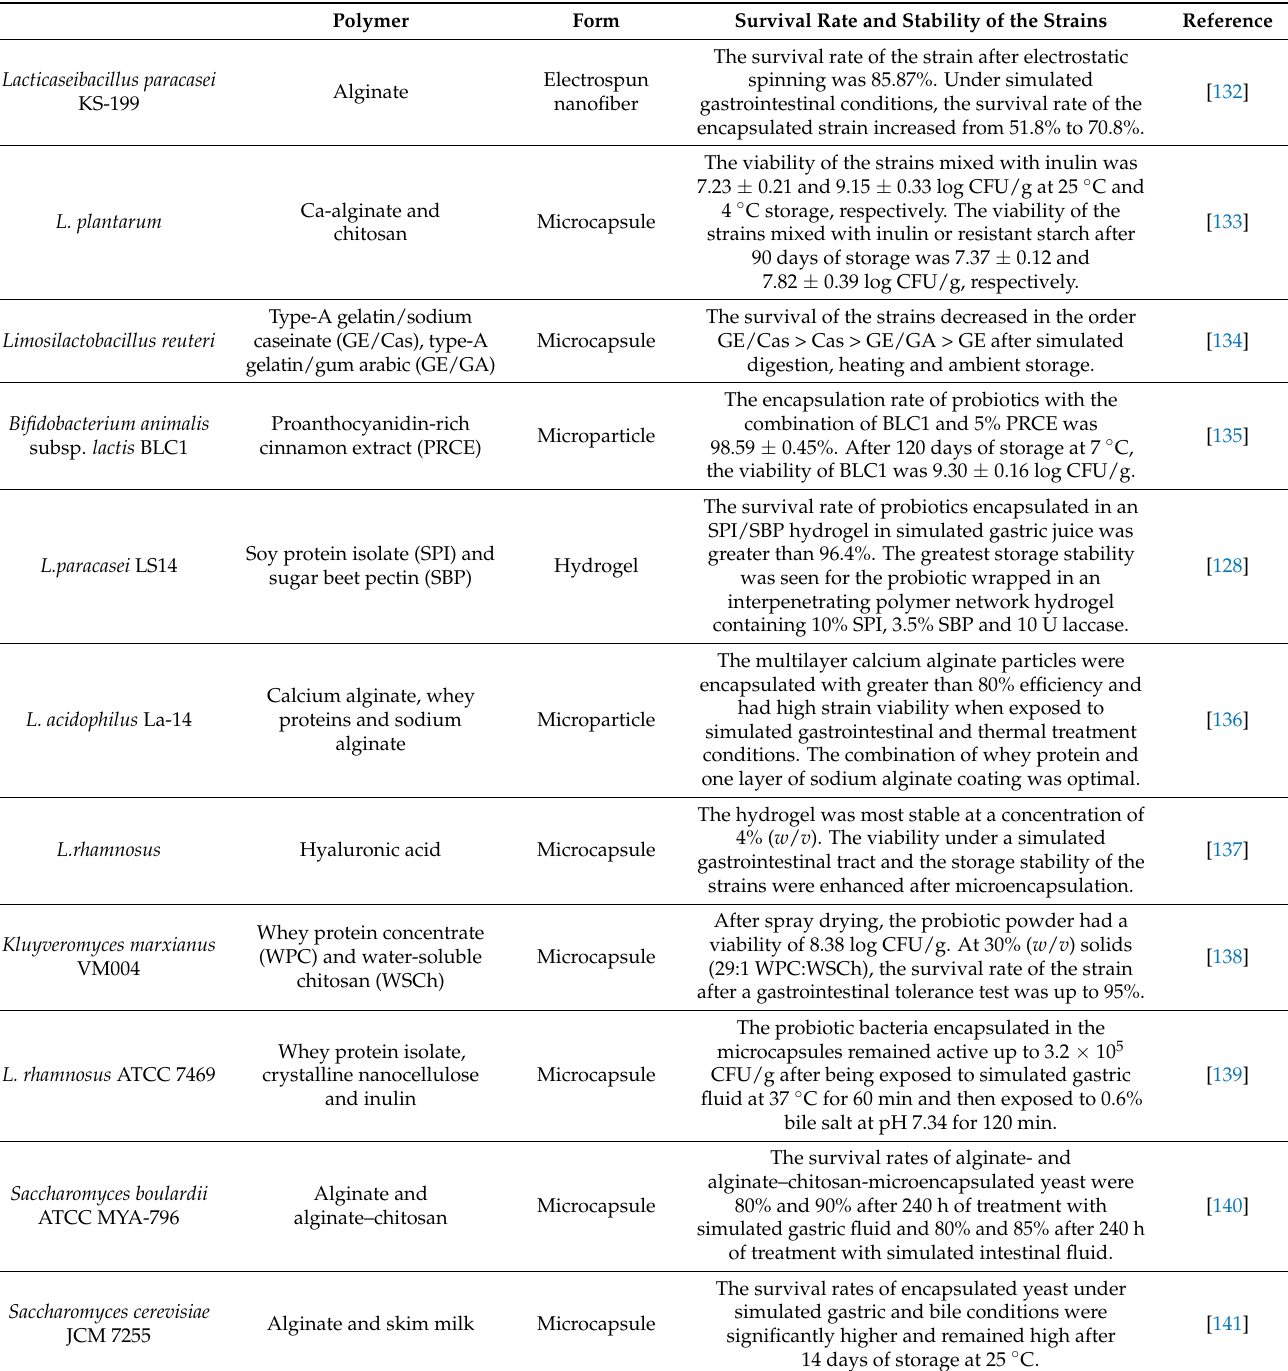
Table 1. Recent studies of different carriers for the targeted delivery of